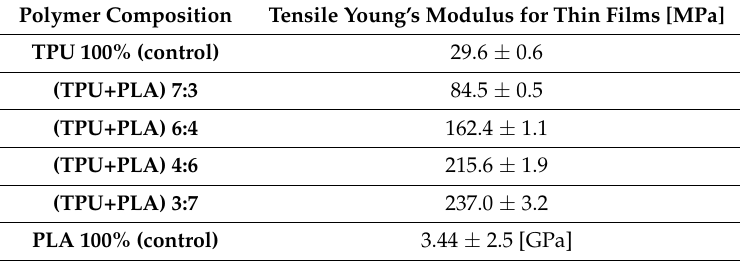
Table 3. Tensile Young’s moduli of thin